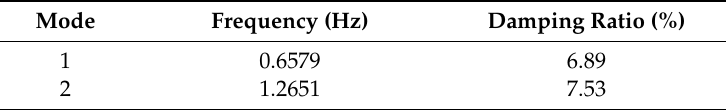
Figure 10. Time domain trajectory of active power from bus 28 to 29.